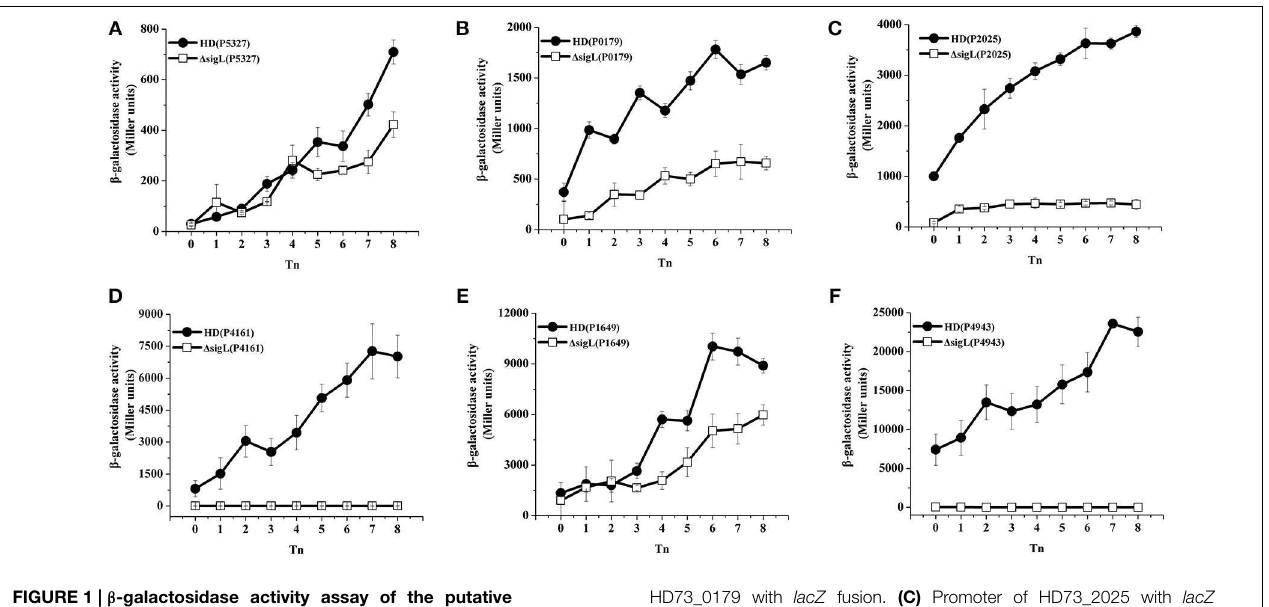
HD73_0179 with lacZ fusion. (C) Promoter of HD73_2025 with lacZ fusion. (D) Promoter of HD73_4161 with lacZ fusion. (E) Promoter of HD73_1649 with lacZ fusion. (F) Promoter of HD73_4943 with lacZ fusion.